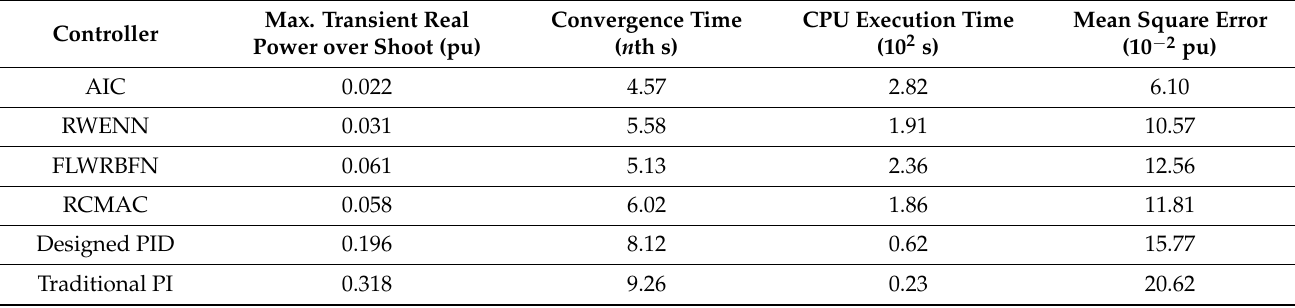
Table 1. Comparison of real power for six controllers with load disturbance.